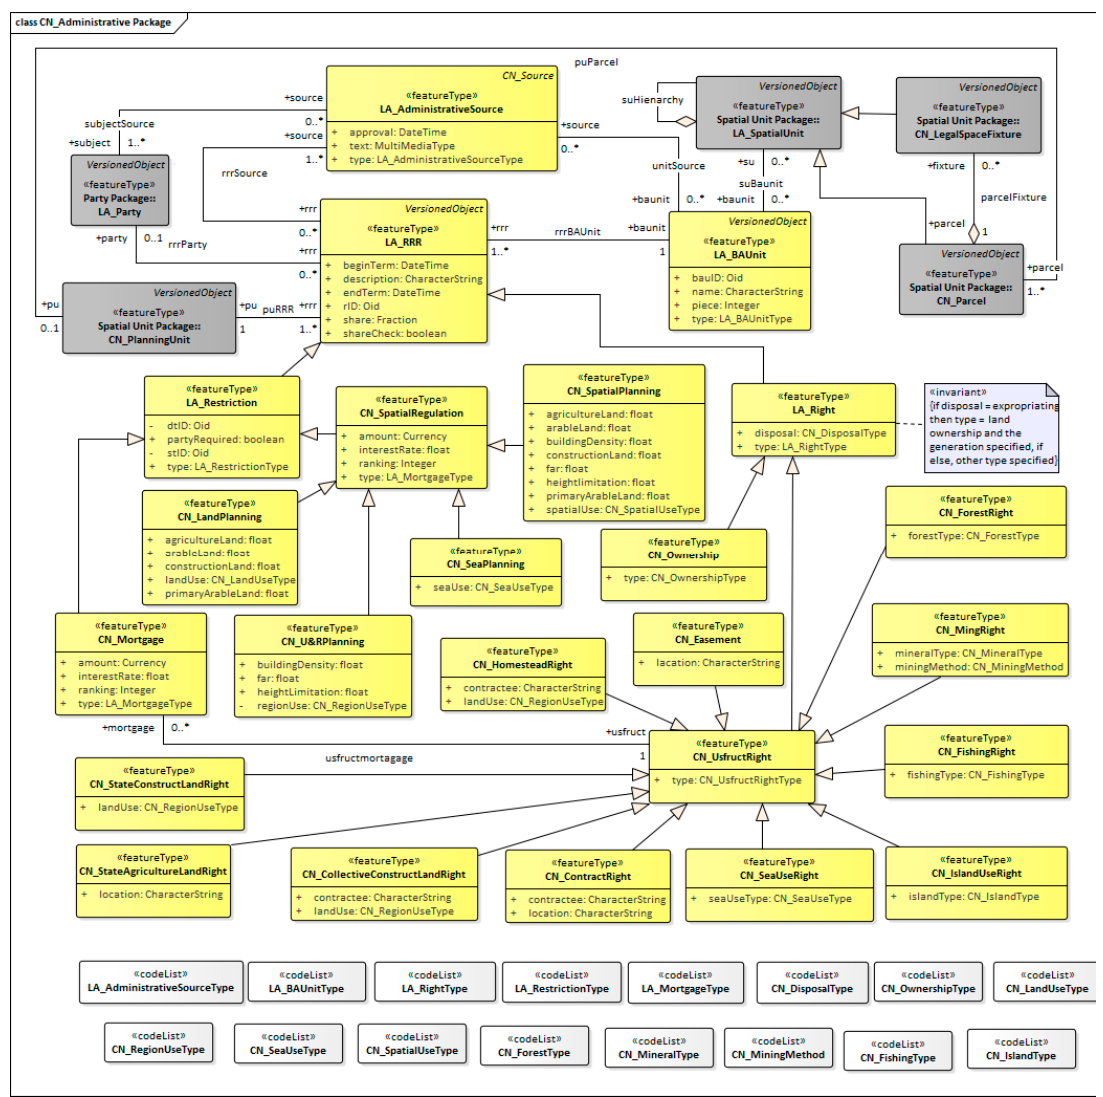
Figure 8. Administrative package with Relationship (“yellow” part).